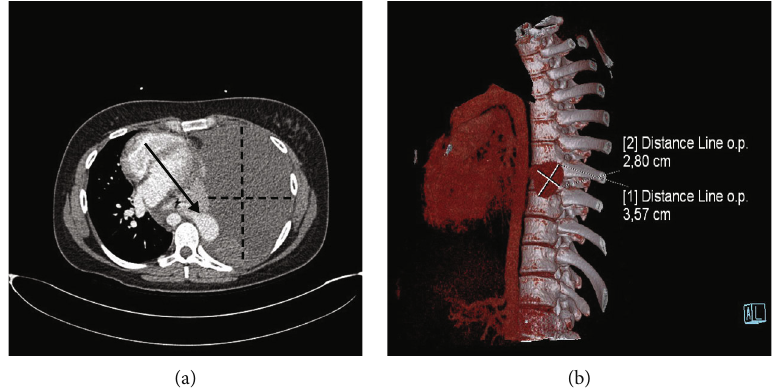
Figure 1: Computed tomography pulmonary angiography at 25 +4 weeks of pregnancy of the patient presented with dyspnea on multiple occasions from 20 weeks of pregnancy. (a) Transversal plane, arrowhead pointing at arteriovenous malformation, and dotted lines indicating diameters of left haemathothorx; (b) isolated mass — arteriovenous